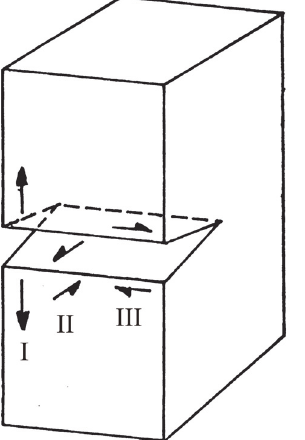
Figure 1: Notation for modes of crack tip surface displacement.